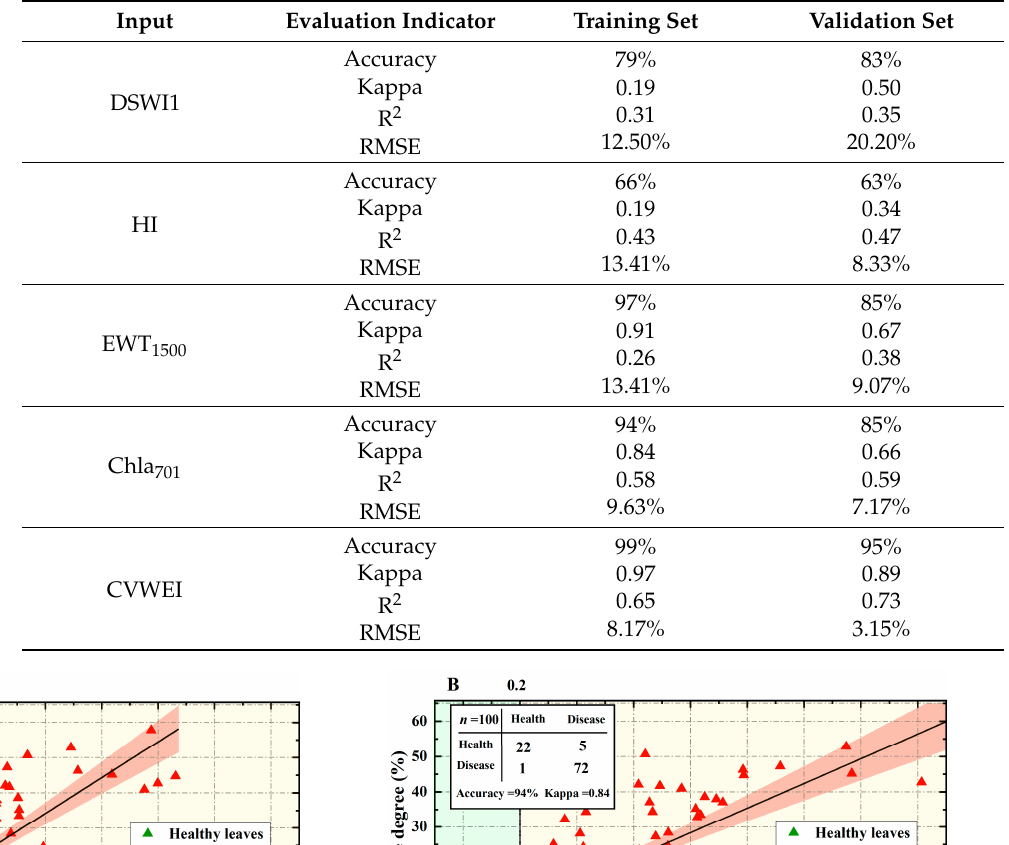
Table 5. Accuracy evaluation of the cotton VW early detection model.